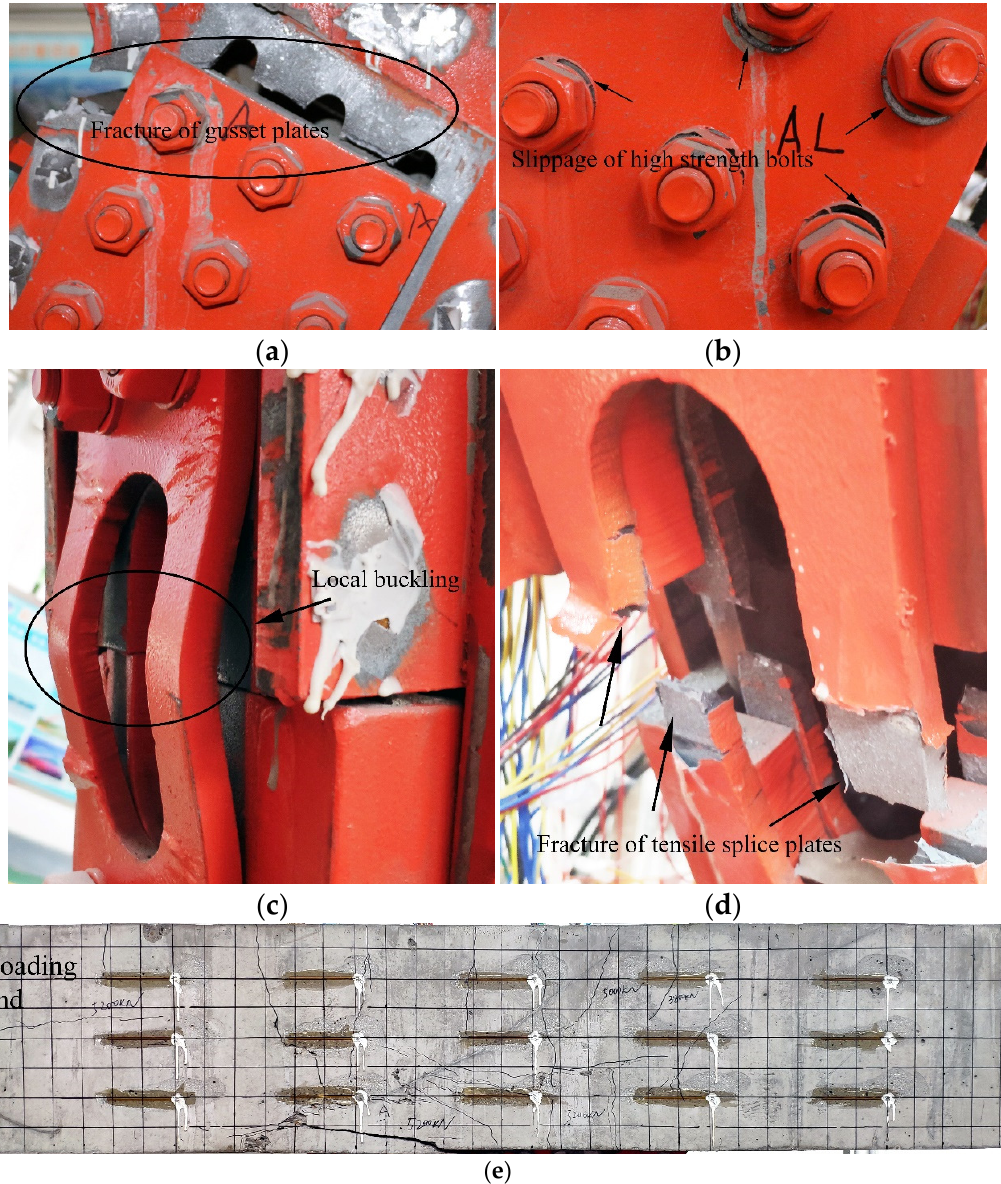
Figure 5. Failure modes of Specimen 1: ( a ) the fracture of gusset plates; ( b ) the slippage of high-strength bolts; ( c ) the local buckling of the compressive splice plates; ( d ) the fracture of the tensile splice plates; and ( e ) the concrete cracking.